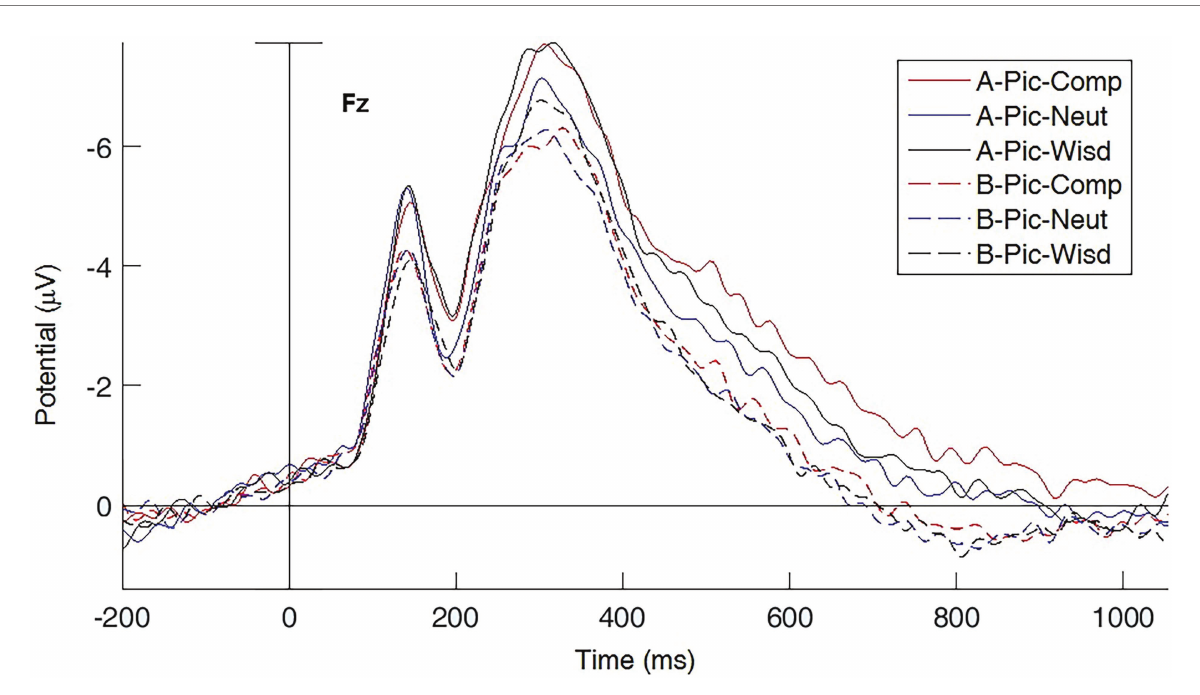
FIGURE 2 The event-related potentials of different priming conditions for negative pictures (Fz channel). The solid lines represent the ATP group and the dashed line is for the control group. ATP, Awareness Training Program; COMP, compassion meditation instruction; NEUT, neutral instruction; WISD, wisdom meditation instruction. A-, ATP group; B-, control